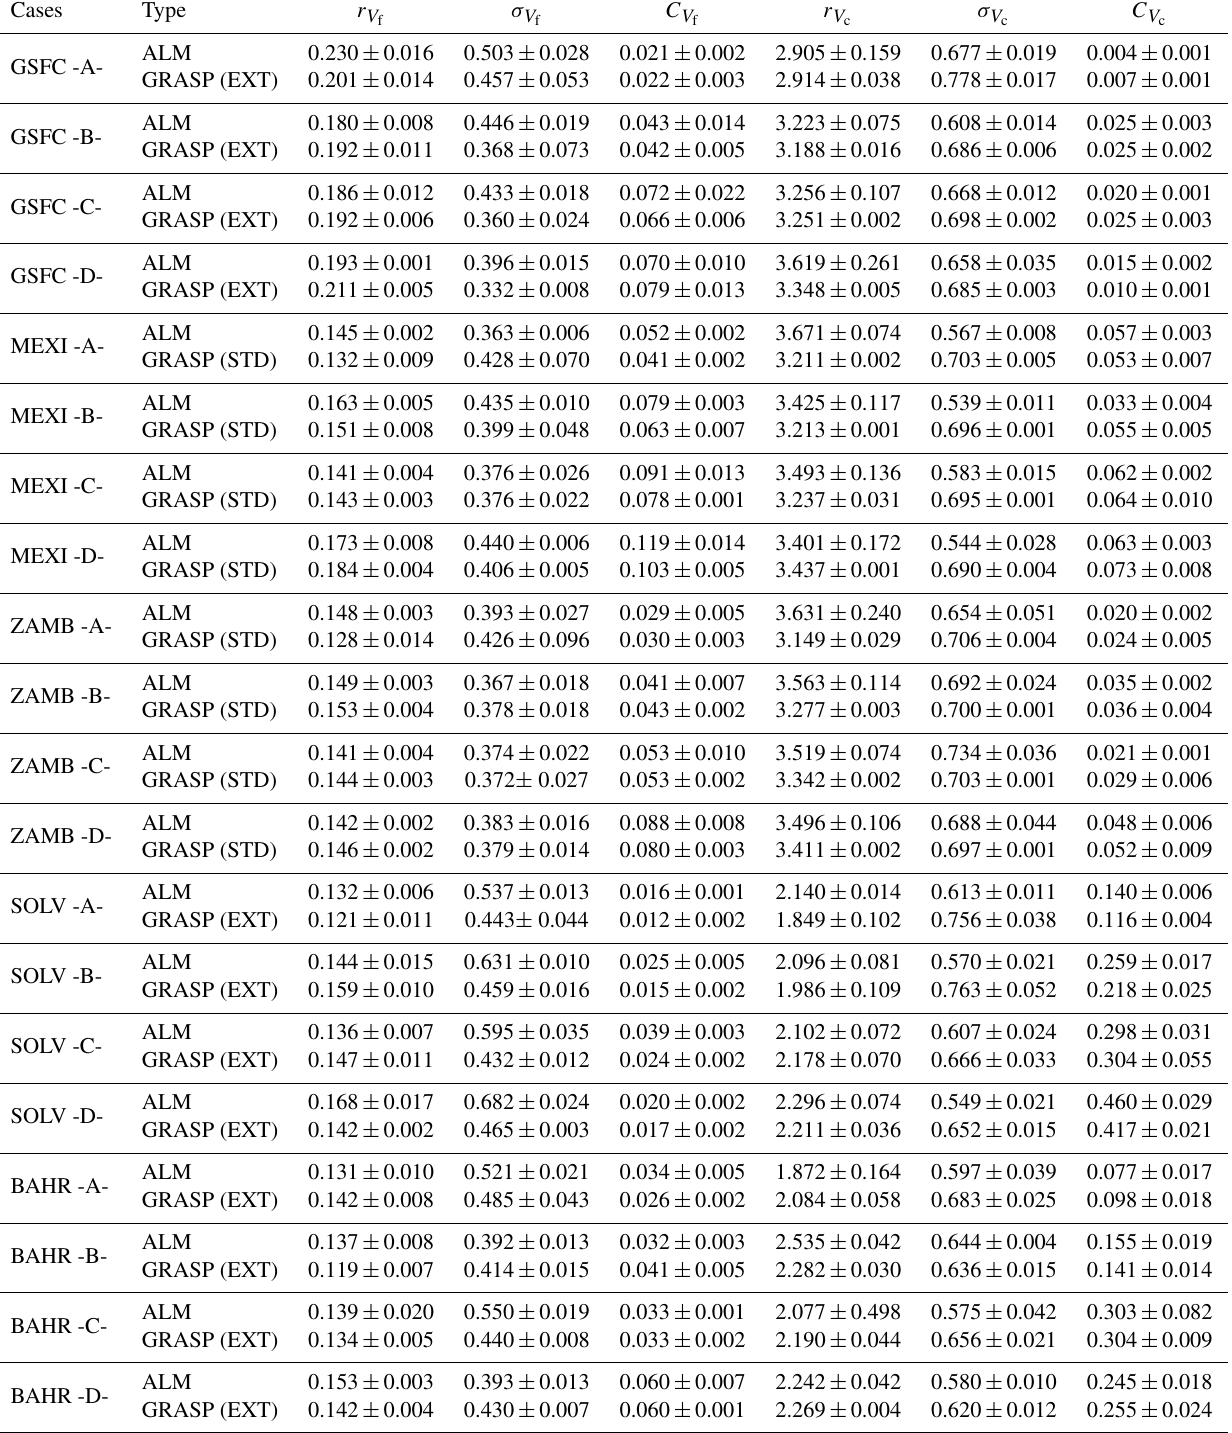
Table 14. Daily average of standard parameters for fine and coarse modes retrieved using AERONET-standard and GRASP-AOD inversion: volume median radius ( r V information about the 29 chosen days is shown in Table